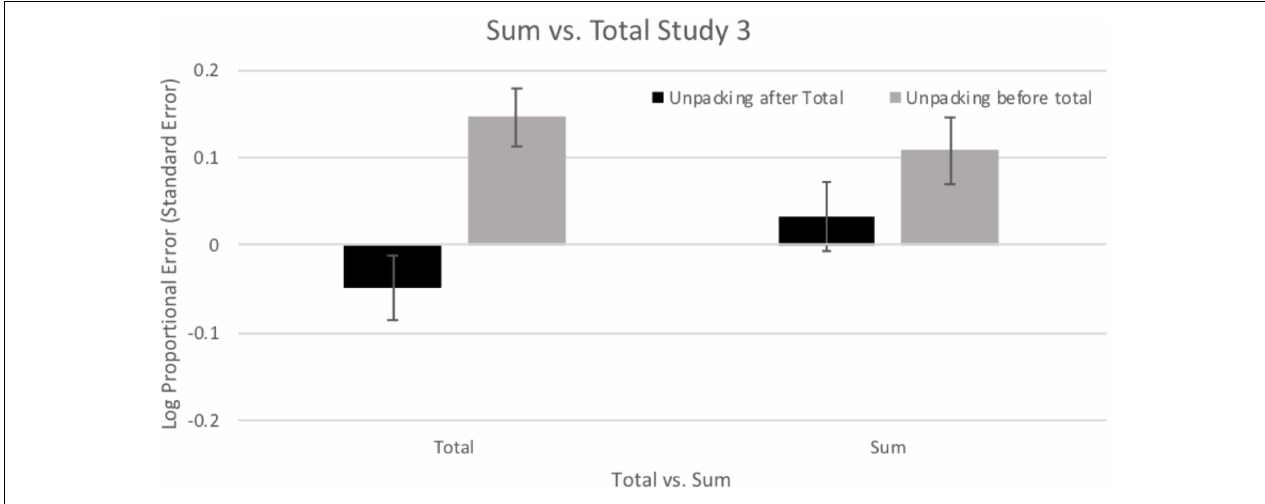
FIGURE 6 | Mean ( ± 1 SE ) bias in estimated duration (log of estimated duration/actual duration) for the total duration estimation and for the sum of the segments. Positive values indicate overestimation and negative values indicate